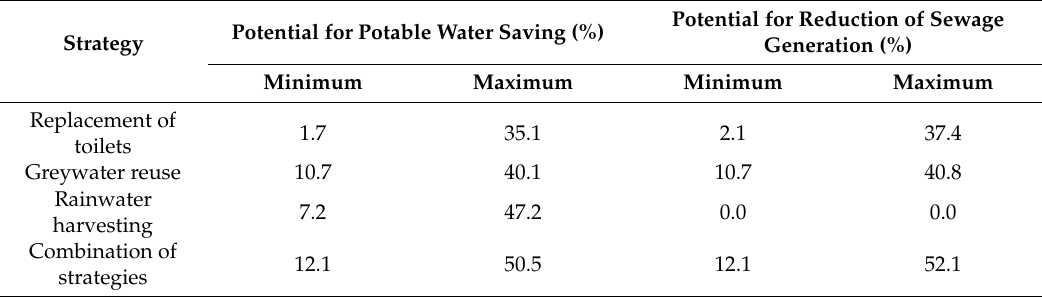
Potential for Reduction of